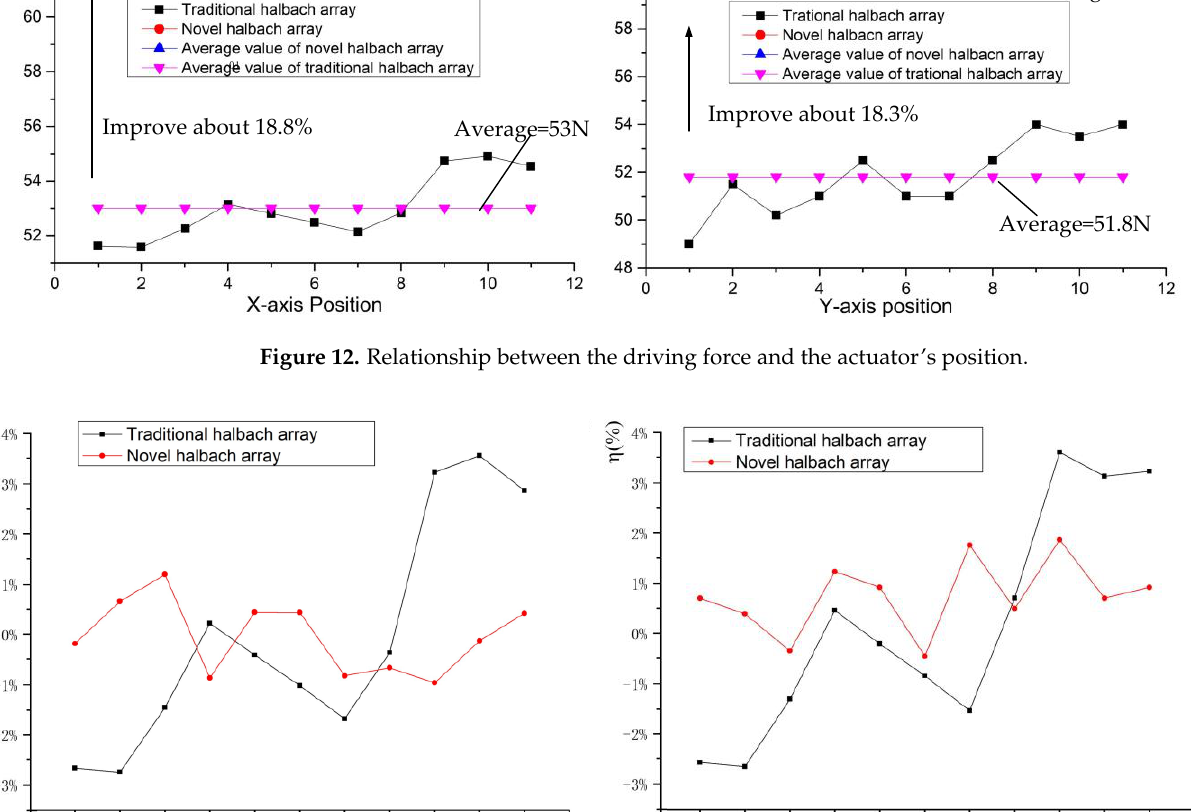
Table 2. The output torques of the two types of